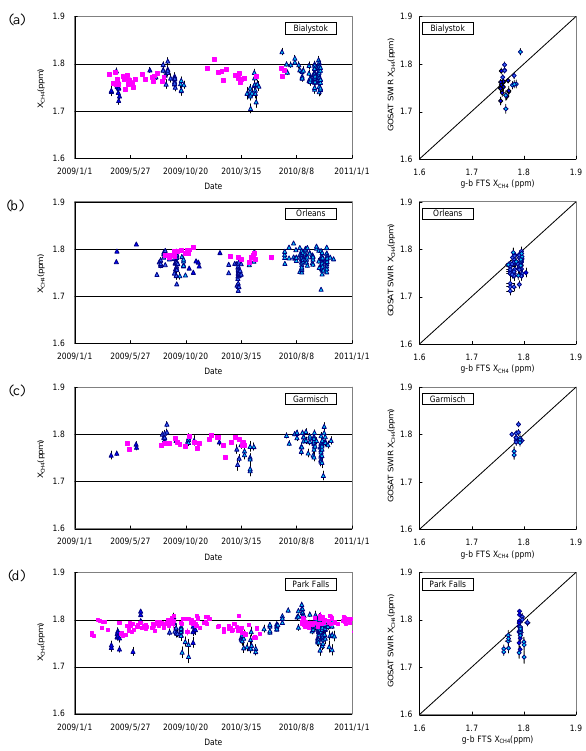
Fig.B4. 5 Fig. B3. Time series of GOSAT TANSO-FTS SWIR (blue trian- gles) and g-b FTS (pink squares) X CH and their scatter diagrams 4 for (a) Bialystok, (b) Orl´eans, (c) Garmisch, (d) Park Falls, (e) La- mont, (f) Tsukuba, (g) Darwin, (h) Wollongong, and (i) Lauder. The GOSAT data were retrieved within ± 5 degrees latitude/longitude box centered at each g-b FTS site and the g-b FTS data were the mean values measured within ± 1 h of GOSAT overpass time.